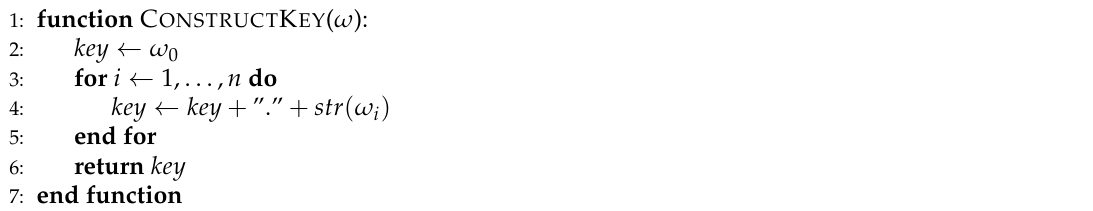
Algorithm 5 Block Lookup Size Key-Size (BLSK-S) weight inheritance key construction